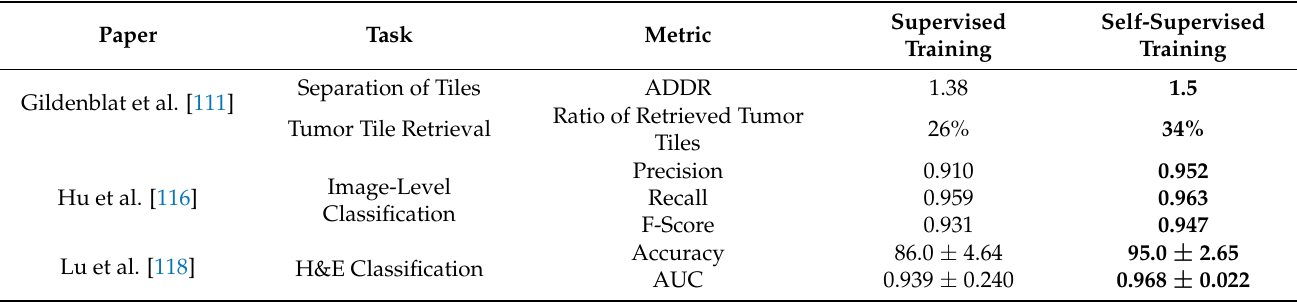
Table 5. A comparison of results yielded by training algorithms using different pretext tasks designed for pathology images versus their supervised counterparts. For Hu et al. [116], the results are averaged over four different runs. In all cases, self-supervised methods outperformed supervised methods.